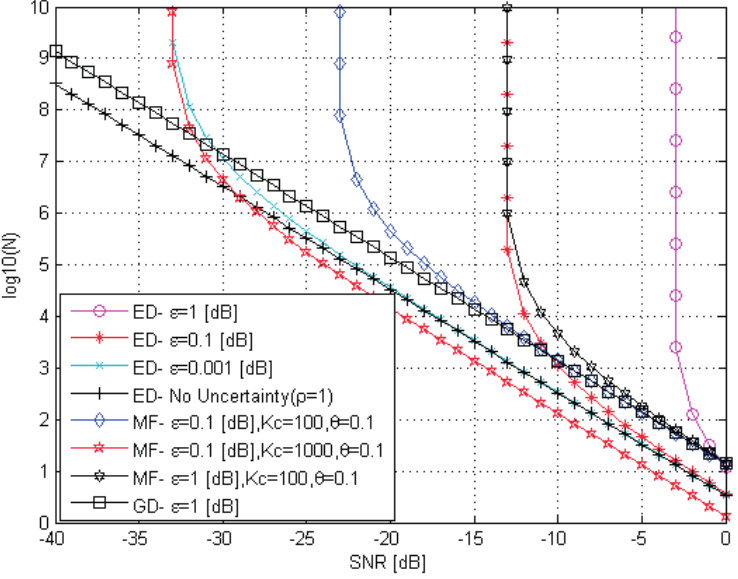
Figure 5. The sample complexity curves of ED, MF, and GD under the noise power